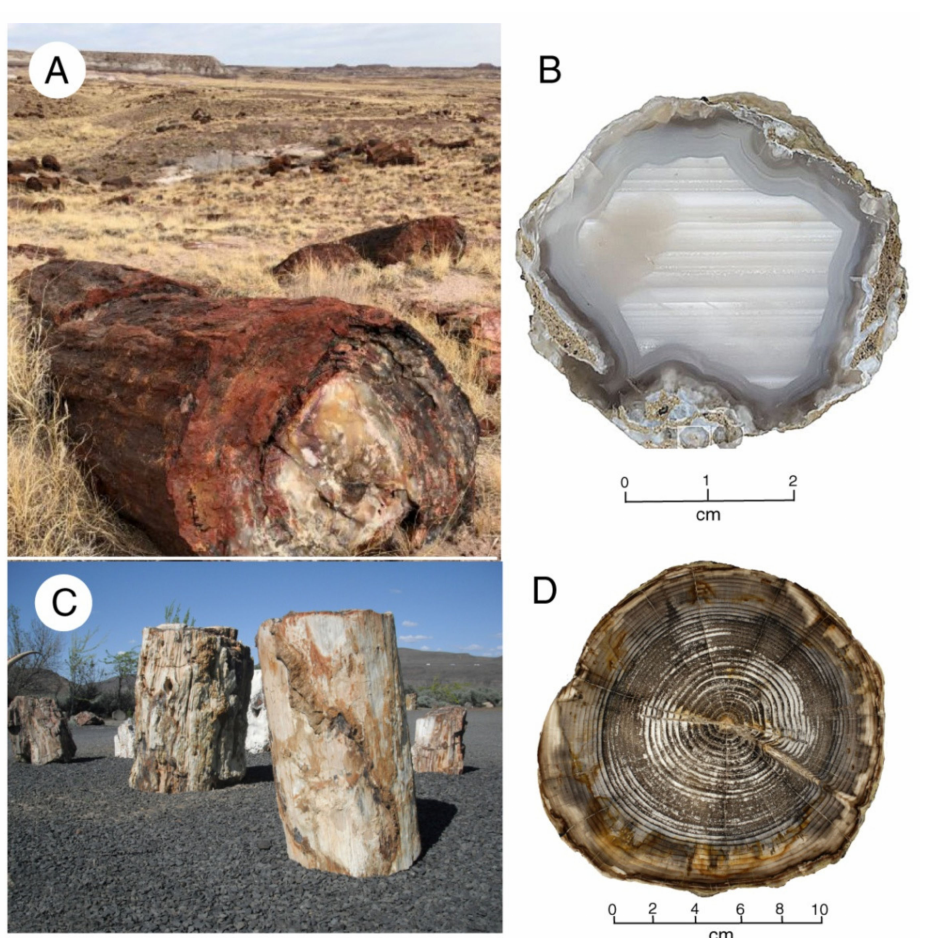
Figure 29. Examples of chalcedony mineralization. ( A ) Petrified Forest National Park, Arizona, USA, Triassic. ( B ) Wiggins Fork locality, near Dubois, Wyoming, USA, Eocene. This is a limb cast where chalcedony initially formed a lining layer within aa natural mold. Internal filling shows parallel geopetal layers that represent the original horizontal orientation of the wood.( C ) Ginkgo Petrified Forest State Park, Washington, USA, Miocene. ( D ) Transverse section of Piceoxylon log, Saddle Mountain, central Washington, USA, Miocene. Photos ( A , B ) courtesy of Mike Viney, photo ( D ) by Tad Dillhoff.